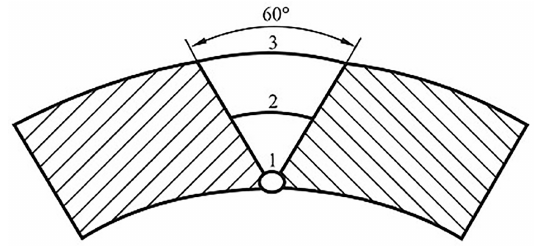
Figure 1. The geometry of the weld structure.